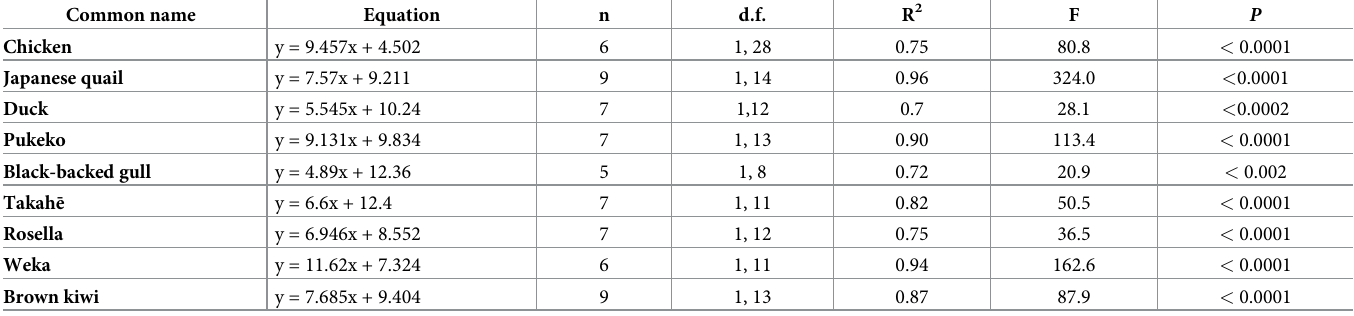
Table 2. Regression of methaemoglobin absorbance index (MAI) with haemoglobin (HbFe 2+ g dL -1 ) in the ferrous (Fe 2+ ) state for individual birds (n) dosed with PAPP at T0 and blood sampled at 60 and 180 minutes with the degrees of freedom (d.f.), R-squared (R 2 ), F-value (F) and significance of the regression fit ( P